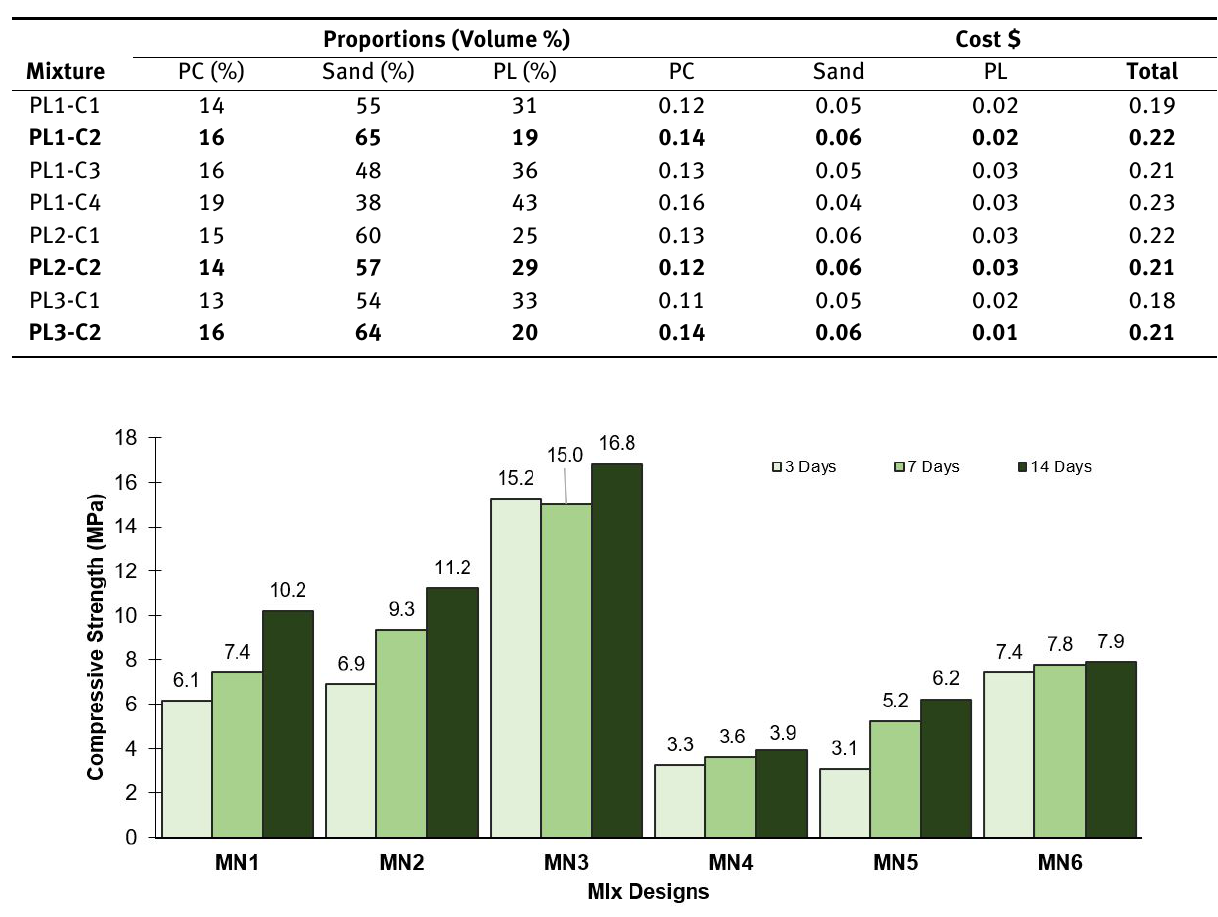
Figure 6: Compressive strength for mixes containing 50% and 100% of coarse aggregate replacement by PL at 3, 7, and 14 days of aging